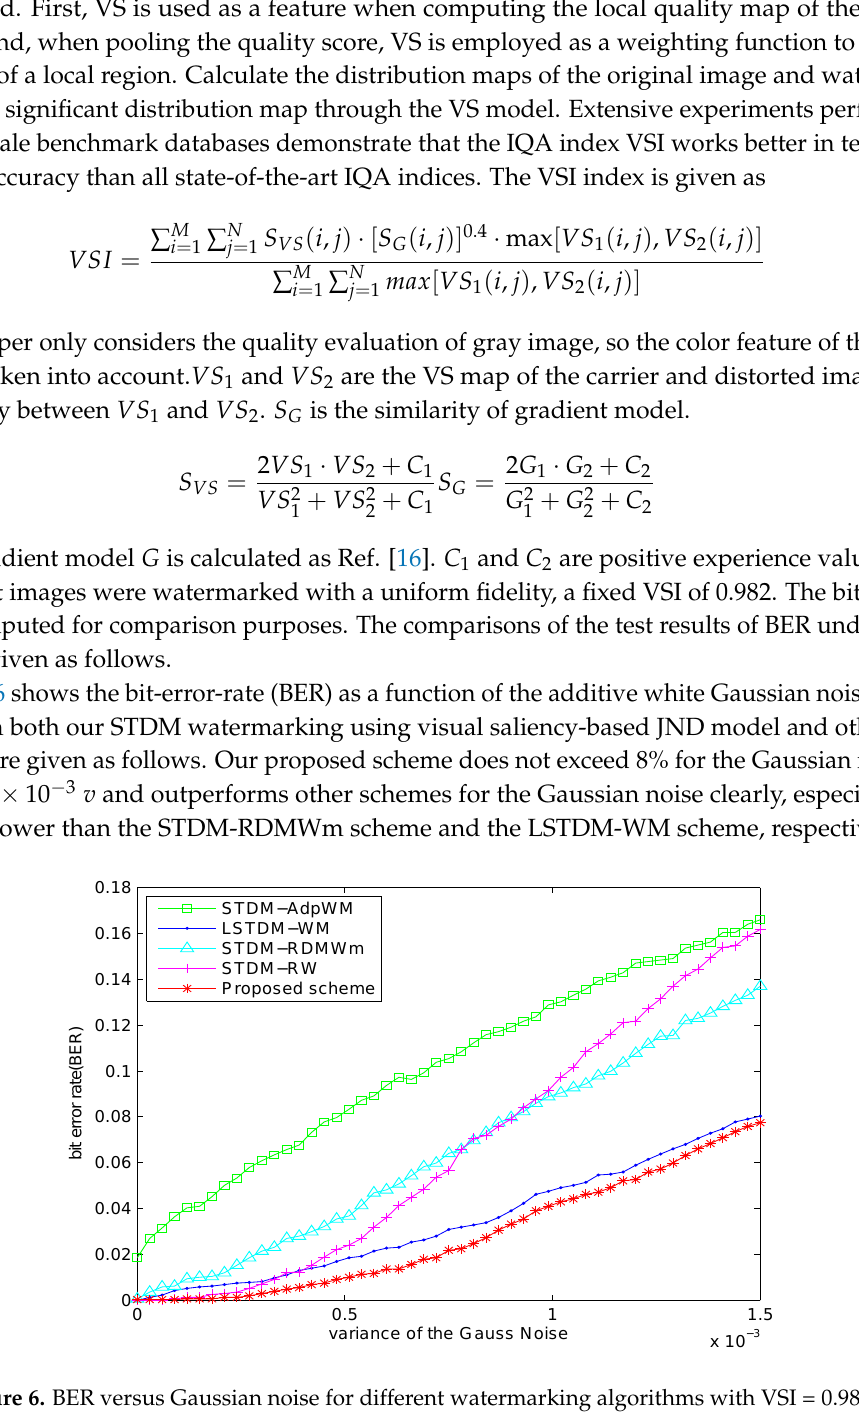
Figure 6. BER versus Gaussian noise for different watermarking algorithms with VSI =